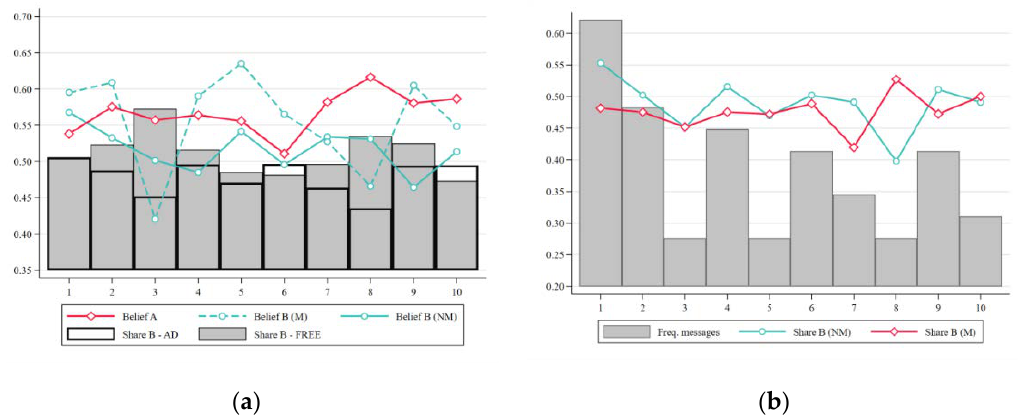
Figure 4. ( a ) Player B’s shares and beliefs in AD and FREE, ( b ) frequency of messages sent in AD. The solid (dashed) line portrays the mean values per period for player B who sent a message in AD. Table 3. Random-e ff ects GLS model for player C’s